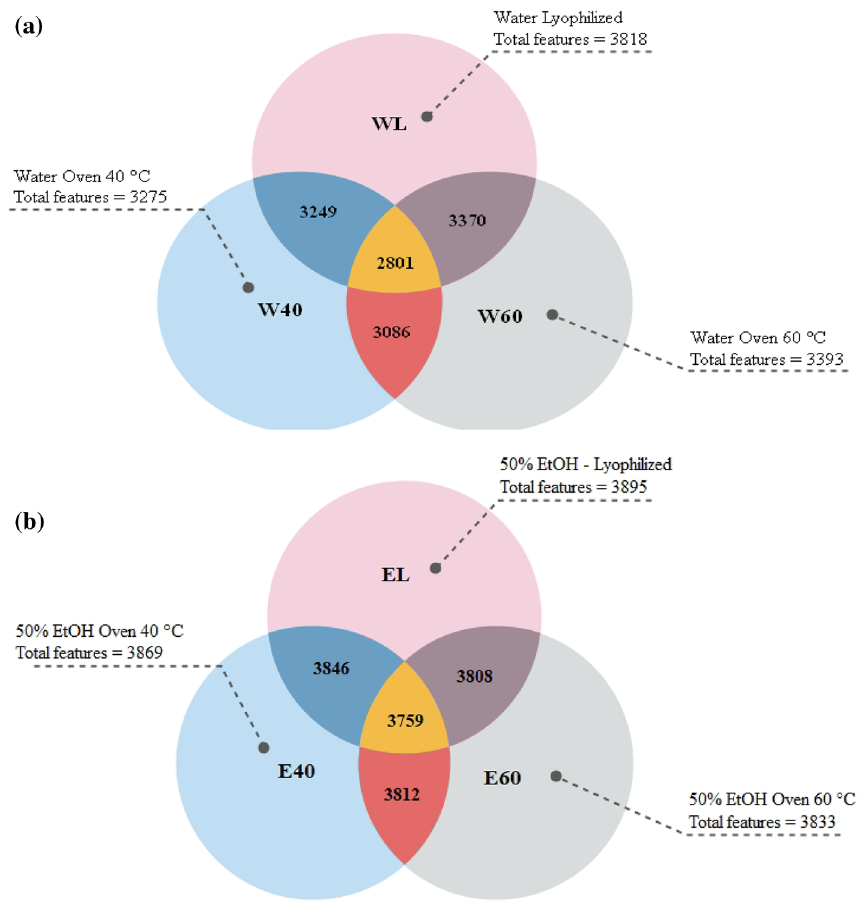
Figure 1. Venn diagram of the detected molecular features using the LC-QToF-MS for A. macrostachyum extracts ( a ) water ( b ) 50% EtOH at different drying